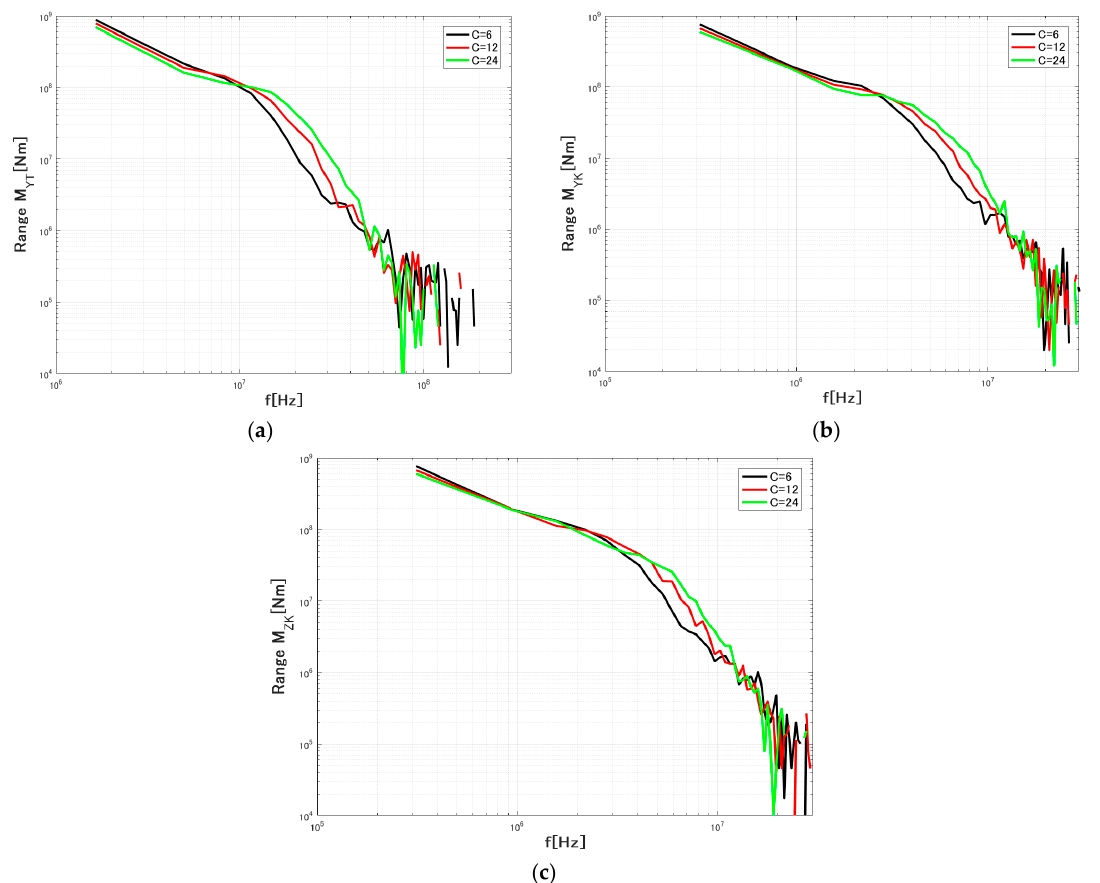
Figure 17. Rain flow cycle to tower load range (8.5 m/s of annual average wind speed): ( a ) tower base fore ‐ aft bending moment; ( b ) tower top nodding moment; and ( c ) tower top yawing moment.